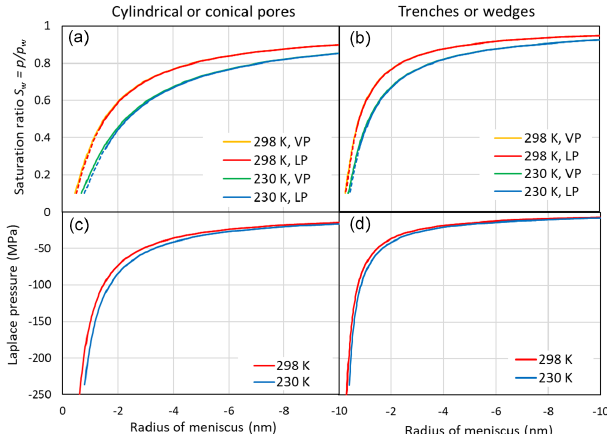
Figure 3. (a, b) Saturation ratio as a function of the meniscus radius of cylindrical or conical pores ( r m , a , c ) and trenches or wedges ( r 1 , b , d ) at 298 and 230K. Saturation ratios are given neglecting the effect of negative pressure on the molecular volume of water (indicated as VP in the legend and calculated using Eqs. 1 and 2) and accounting for the Laplace pressure exerted on the porewater (indicated as LP and calculated using Eqs. 8 and 10). The dashed portions of the red and blue lines indicate the extrapolation of the molecular volume to strongly negative pressures as shown in the lower panels. (c, d) Laplace pressure as a function of the radius of the